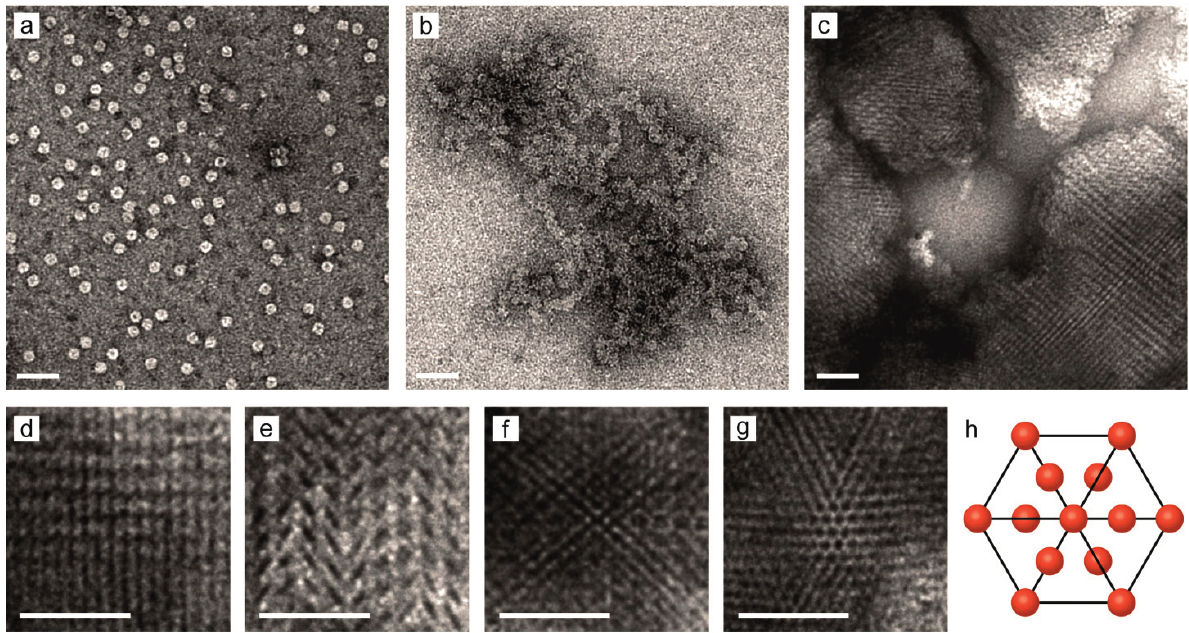
Figure 4. Negatively stained (uranyl acetate) TEM images of: ( a ) Free aFT particles ( b ) aFT- 4 complexes in the absence of NaCl are large and amorphous; ( c ) aFT- 4 complexes prepared in the presence of 10 mM NaCl show large crystalline domains; ( d – g ) Crystalline assemblies viewed along different projection axes; and ( h ) fcc unit cell viewed along the [111] zone axis. Scale bars are 50 nm in all